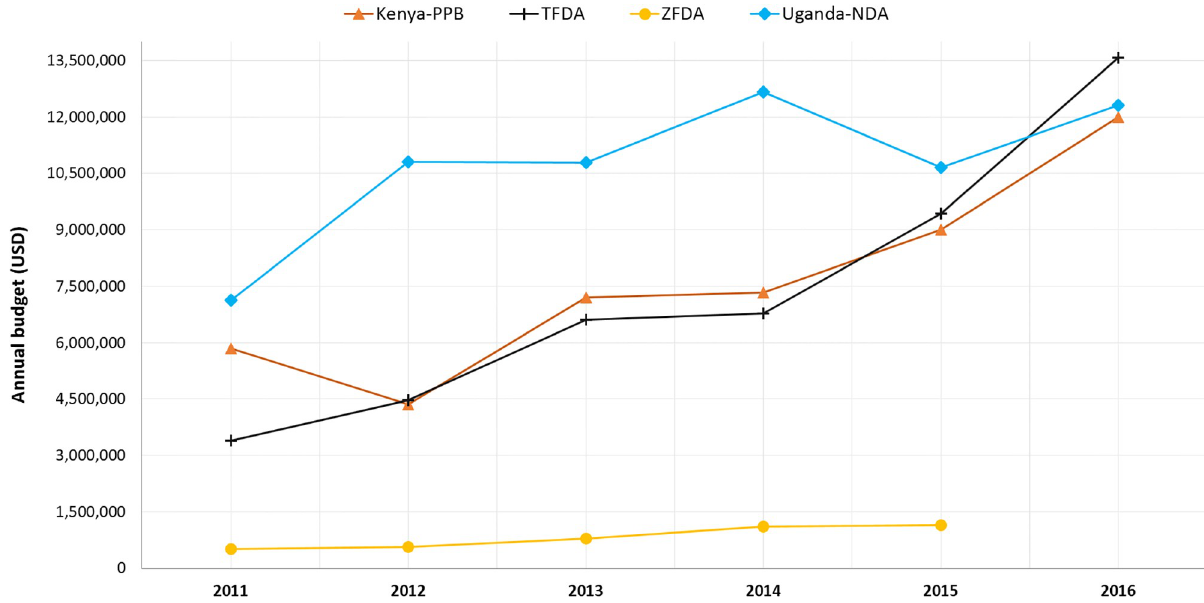
Fig 1. Trends in East African Community national medicines regulatory authorities’ annual